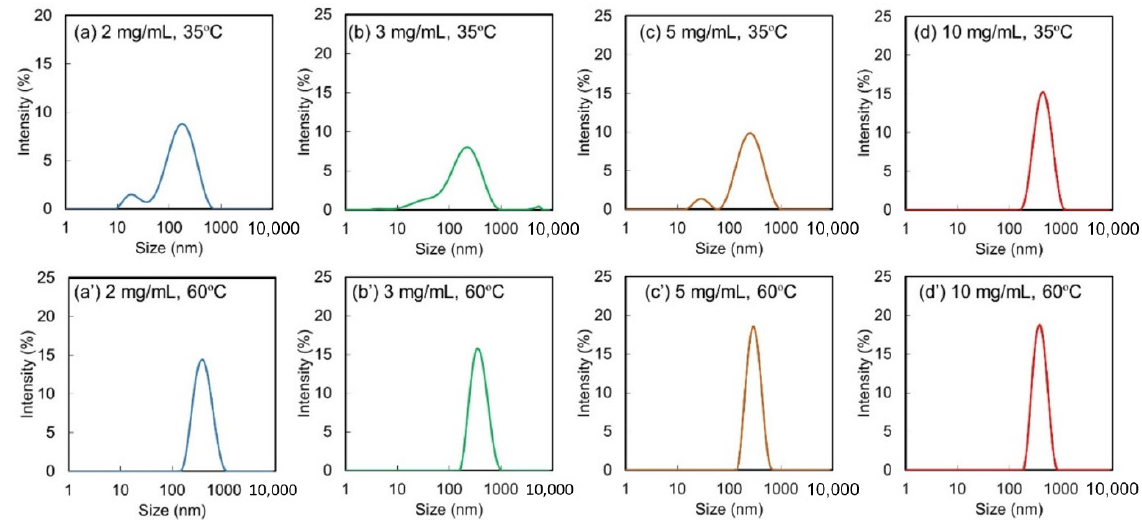
Figure 2. Particle size distributions of PG 1000 particles at 35 °C ( a – d ) and 60 °C ( a ′ – d ′). PVA 1000 concentrations: 2 ( a , a′ ), 3 ( b , b′ ), 5 ( c , c′ ), and 10 ( d , d′ ) mg/mL. PG 1000 particles were prepared via dispersion polymerization with different PVA 1000 concentrations (2, 3, 5, and 10 mg/mL) at 70 ◦ C for 3